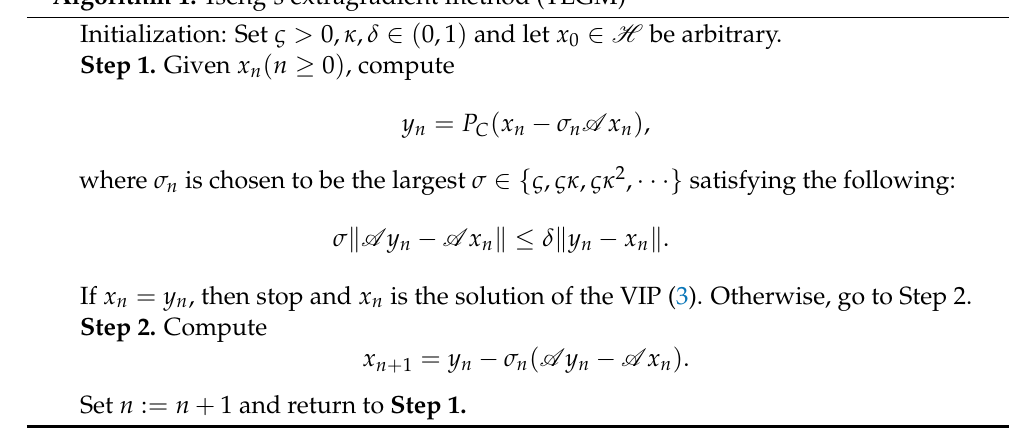
Algorithm 1: Tseng’s extragradient method